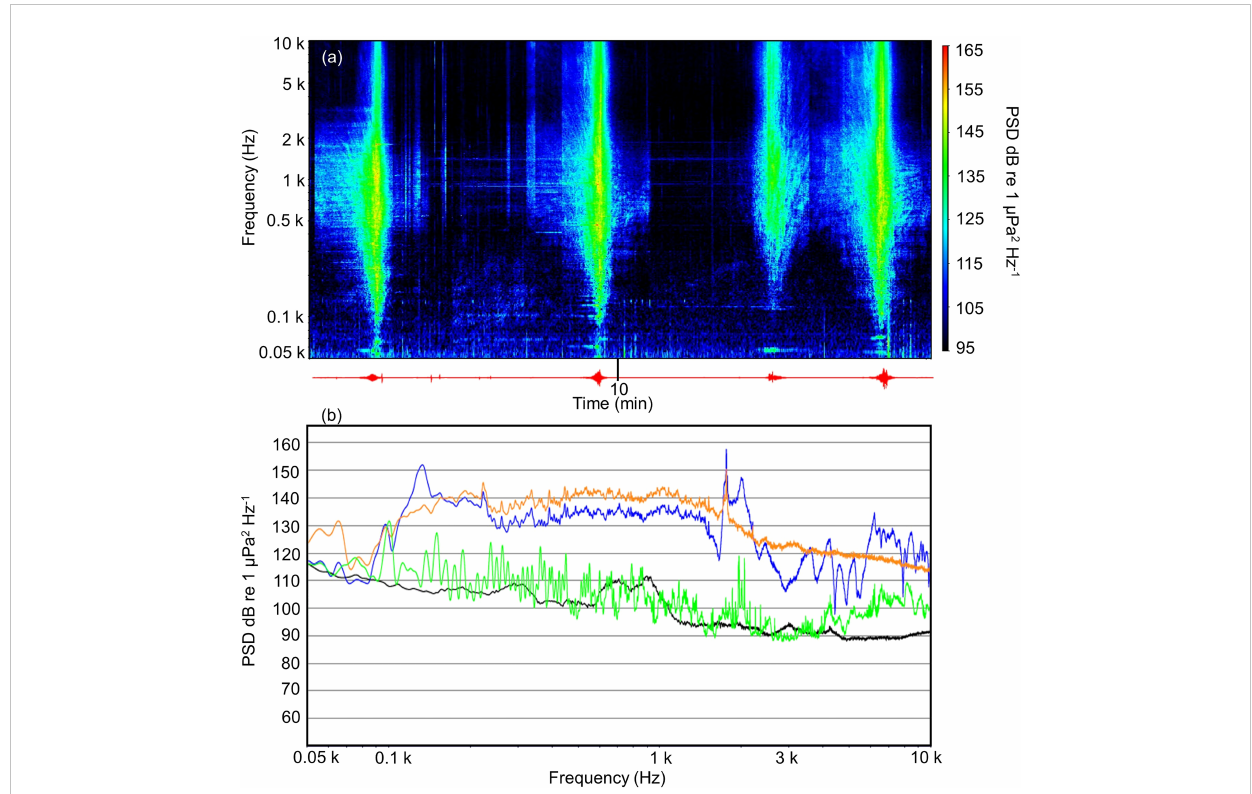
FIGURE 2 Sound exposure. (A) Spectrogram from the original harbor traf fi c noise recording. The left y-axis shows the frequency in Hertz. The right y-axis presents the color code for the power spectral density (dB re 1 µ Pa 2 Hz − 1 ). The x-axis presents the recording as time series in minutes (red line). (B) Spectrum of the fi rst boat (see (A) 1 ’ 36 ” to 2 ’ 14 ” ) passing the hydrophone in the original recording (orange line) and the exposure sound measured in the aquarium in the experimental beaker (blue line). The green line shows the ambient aquarium sound spectrum. The black line represents the ambient fi eld sound from the copepod catching site. All samples had a length of 38 s. The fi gures are presented in a Hanning window (50% overlap), frequency resolution is 3 Hz, visualized in SpectraPlus-SC (V 5.3.0.